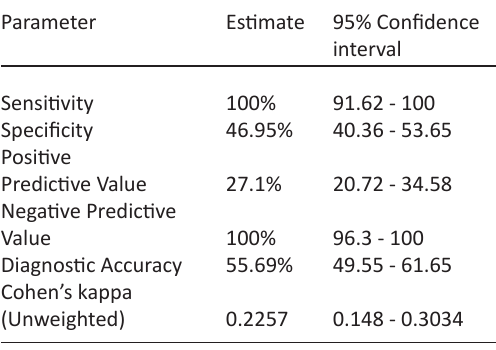
Table 2. Performance of CLIA in comparison with TPHA Table 1. Comparison of CLIA results with RPR and TPHA